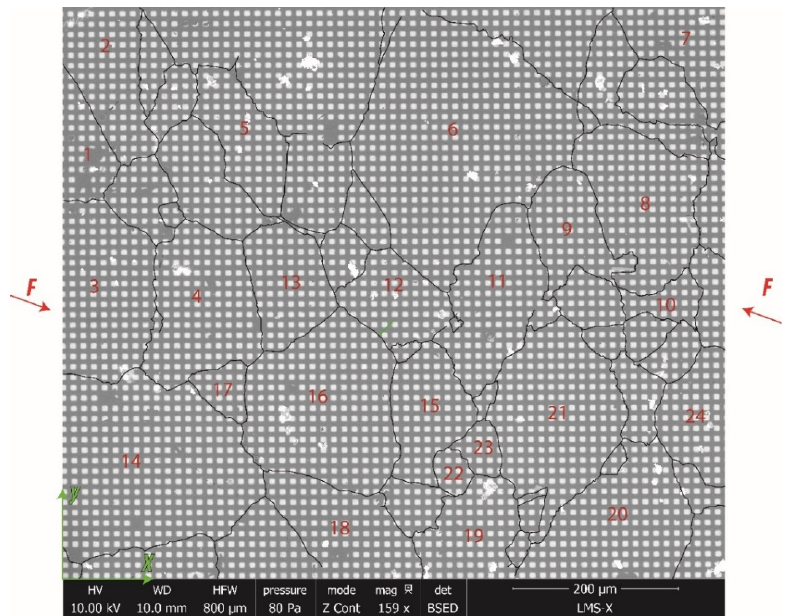
Figure 4. Step 0 shot of the deformation of a Carrara marble sample. The SEM parameters of the image are indicated at the bottom of the image. The gold marking is visible with the grid of squares highlighted. The grain boundaries have been redrawn to better distinguish them. The numbering corresponds to the crystals that were twinned during the experiment. The red arrow indicates the direction of the applied force.